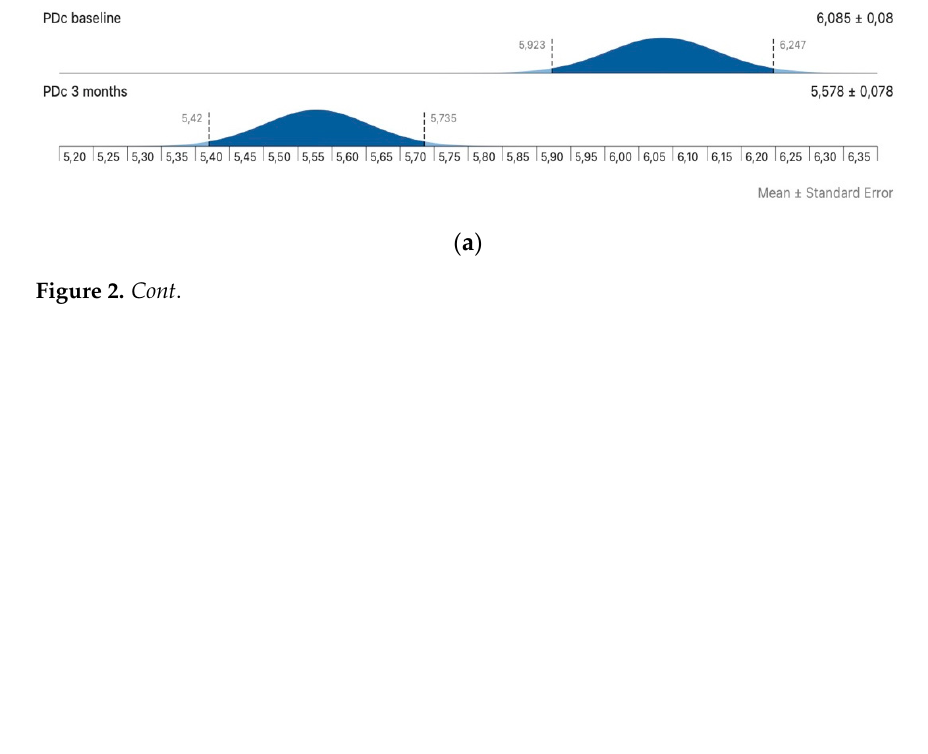
Figure 1. Comparaison at baseline between ( a ) probing depth values (PDc: probing depth in SRP alone sites; PDs: probing depth in SRP + L. reuteri sites); ( b ) clinical attachment loss (CALc: clinical attachment loss in SRP alone sites; CALs: clinical attachment loss in SRP + L. reuteri sites); ( c ) bleeding on probing values (expressed in %) (BOPc: bleeding on probing in SRP alone sites; BOPs: bleeding on probing in SRP + L. reuteri sites).